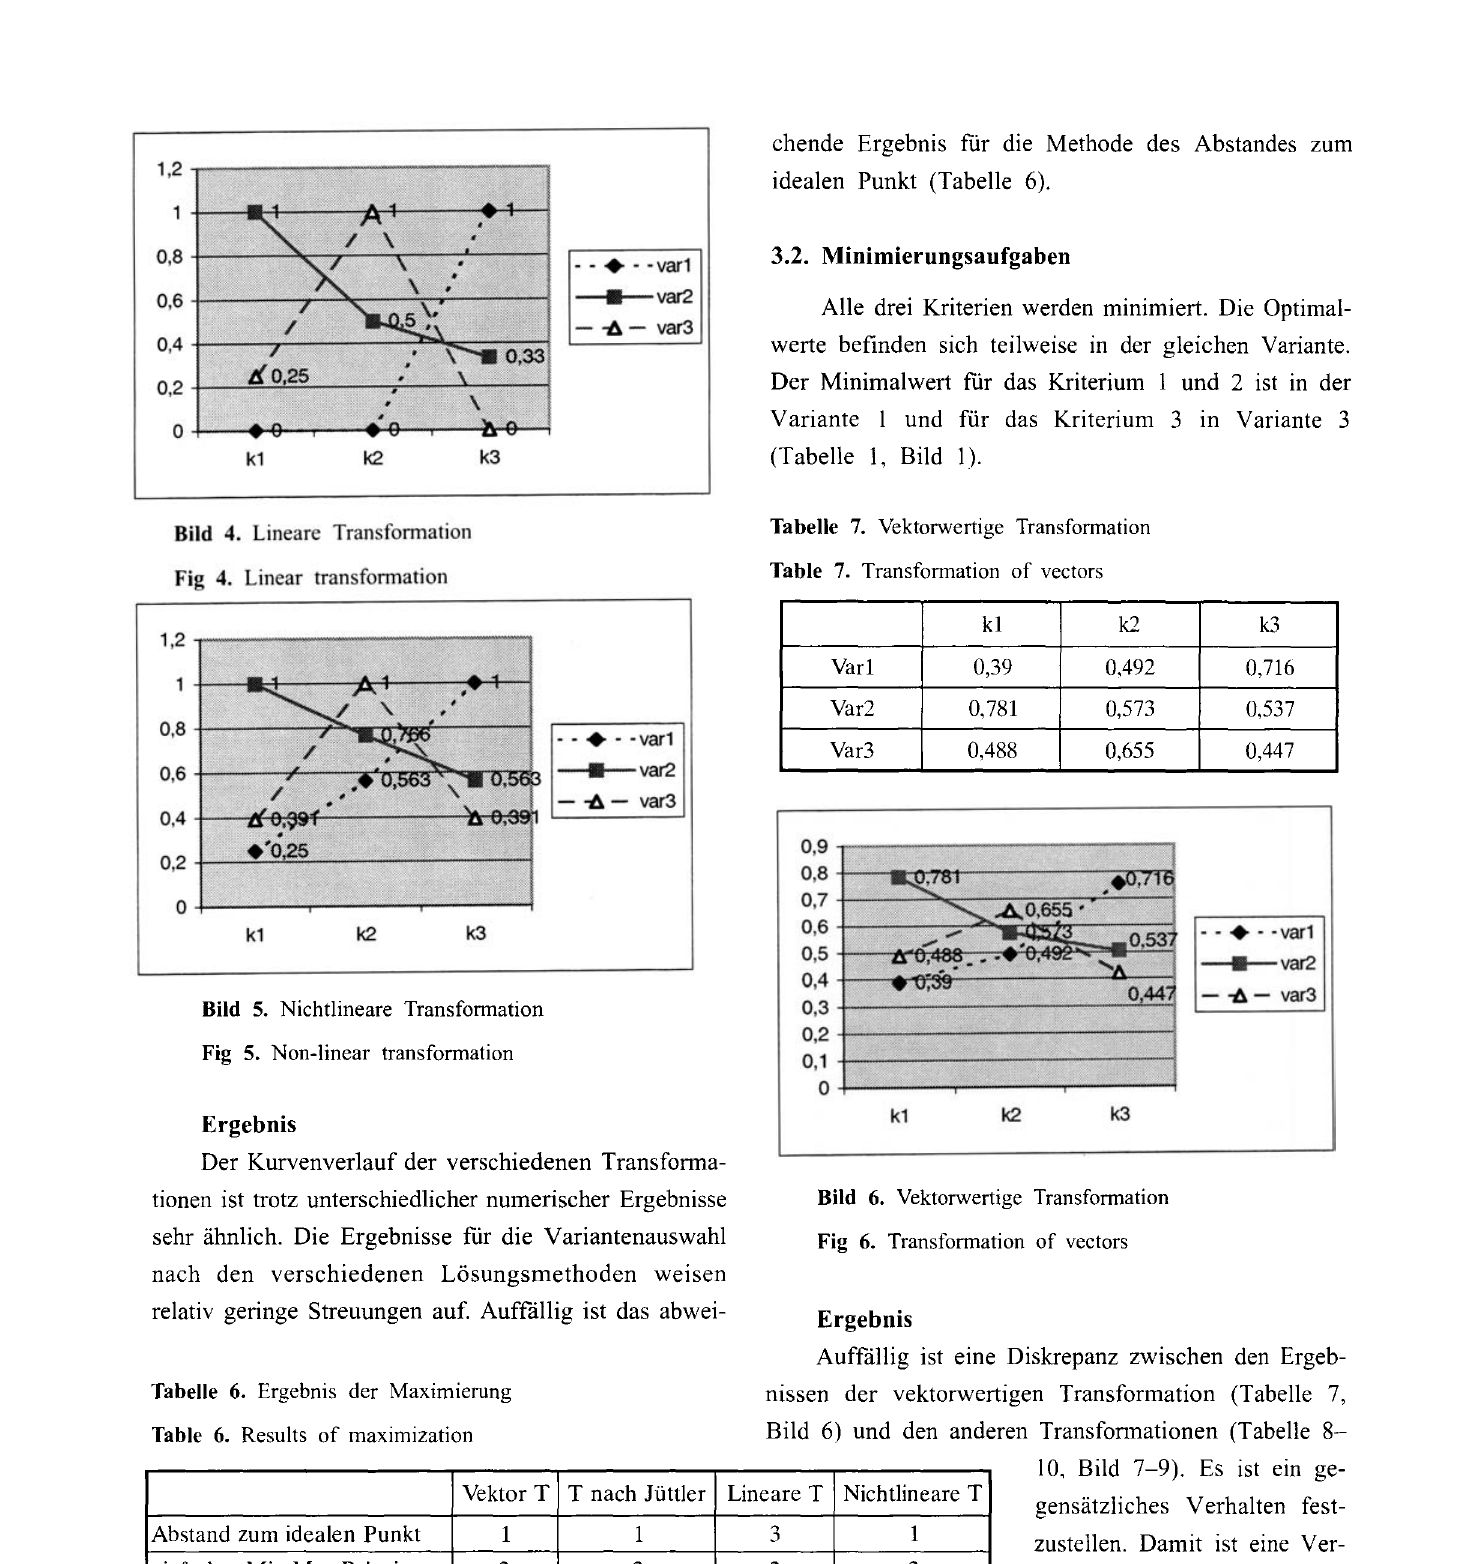
Table 6. Results of maximization